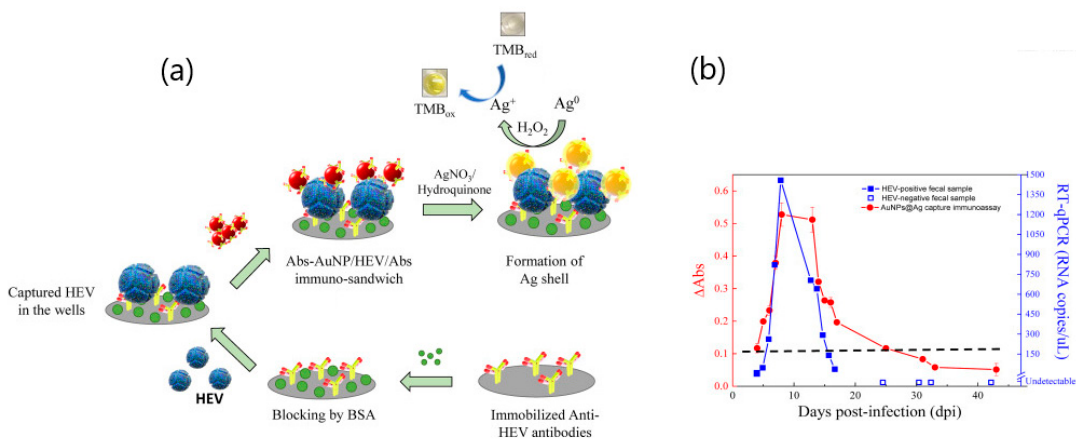
Figure 12. ( a ) Schematic principle of the silver-deposited, gold nanozyme-based capture immunoassay representing the binding of Ab(antibody)-AuNPs on the captured HEV-LPs (hepatitis E virus-like particles), Ag-shell deposition on the on the surface of AuNPs, and color development by the catalytic oxidation of tetramethylbenzidine (TMBZ) by Ag + and H 2 O 2 . ( b ) Comparison of the HEV detection sensitivity between the proposed AuNPs@Ag capture immunoassay (closed circles) and RT-qPCR (closed squares) in fecal specimens (error bars represents the standard deviation of triple measurements). Open squares represent the viral RNAs, which are undetectable in RT-qPCR. Surface of AuNPs. The developed color was measured at 450 nm with reference wavelength of 655 nm. Adapted with permission from Khoris et al. [71] Copyright © (2020) Elsevier.